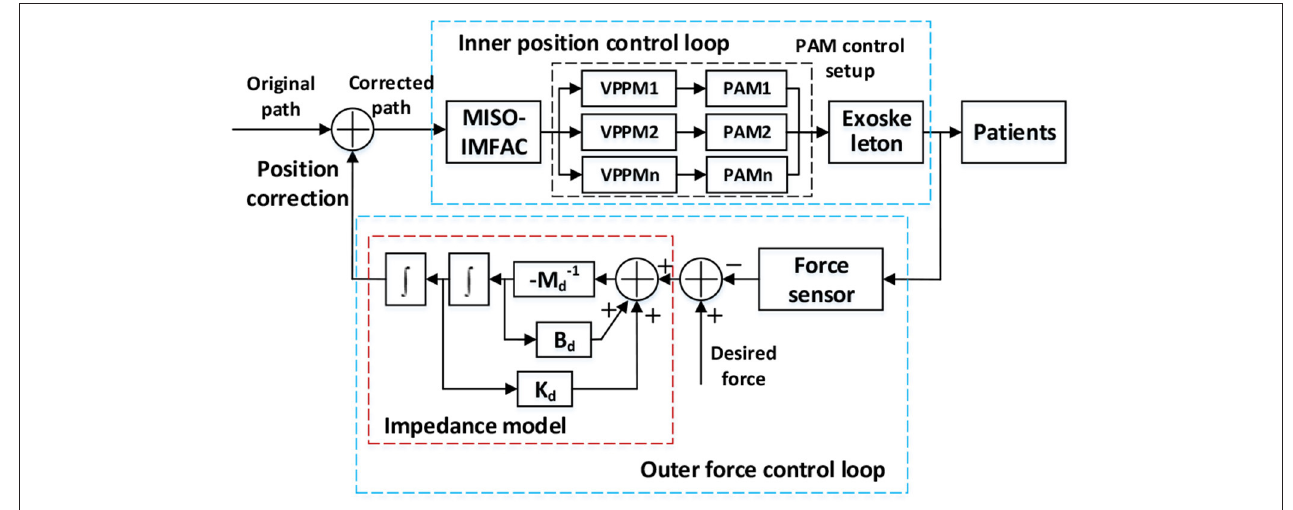
FIGURE 7 | The position-based impedance control scheme for the exoskeleton with PAM control